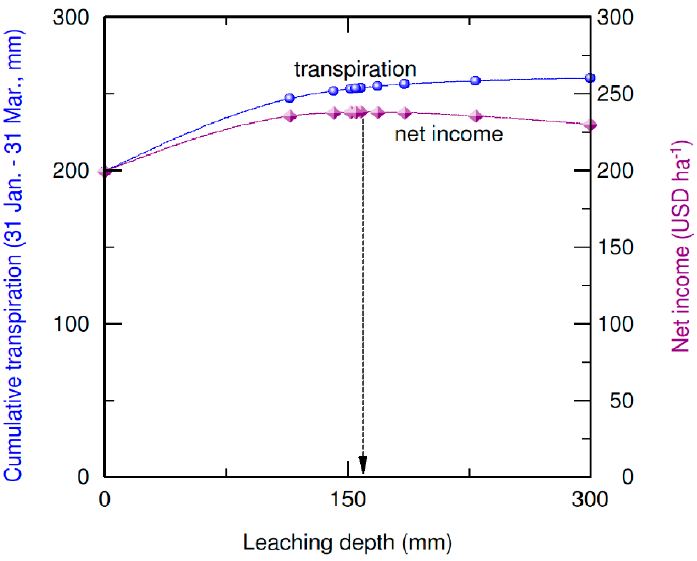
Figure 5. Transpiration amount and increment of net income from 31 January to 31 March as a function of leaching depth in Scenario 4. Those leaching depths are trials during the search of maximum with the golden section